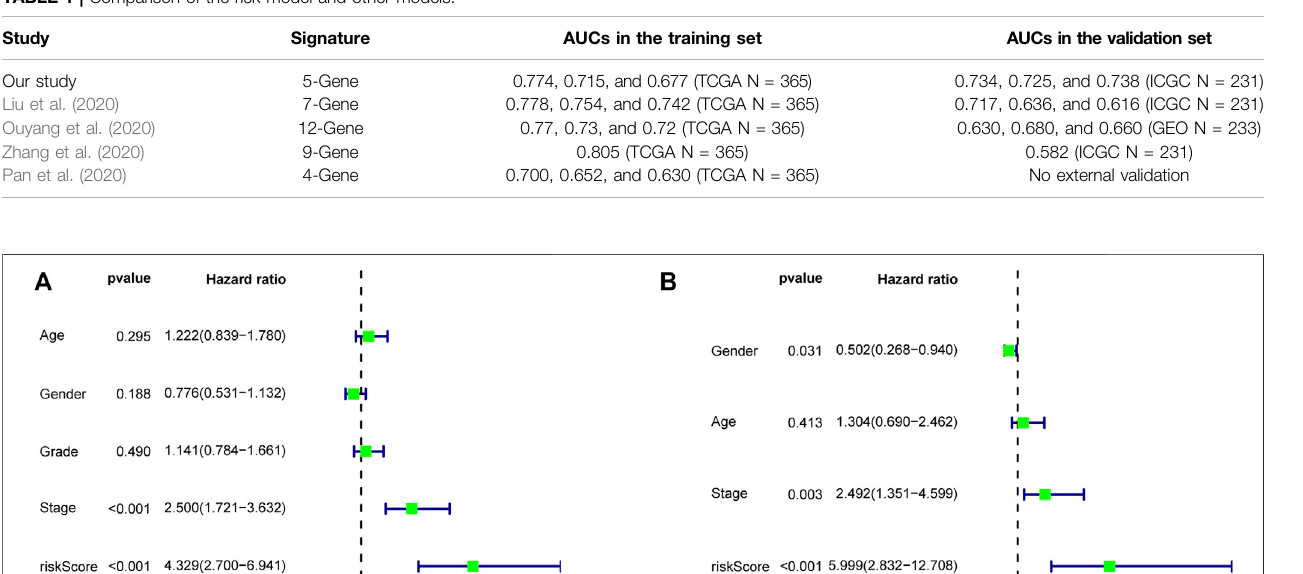
Frontiers in Molecular Biosciences |